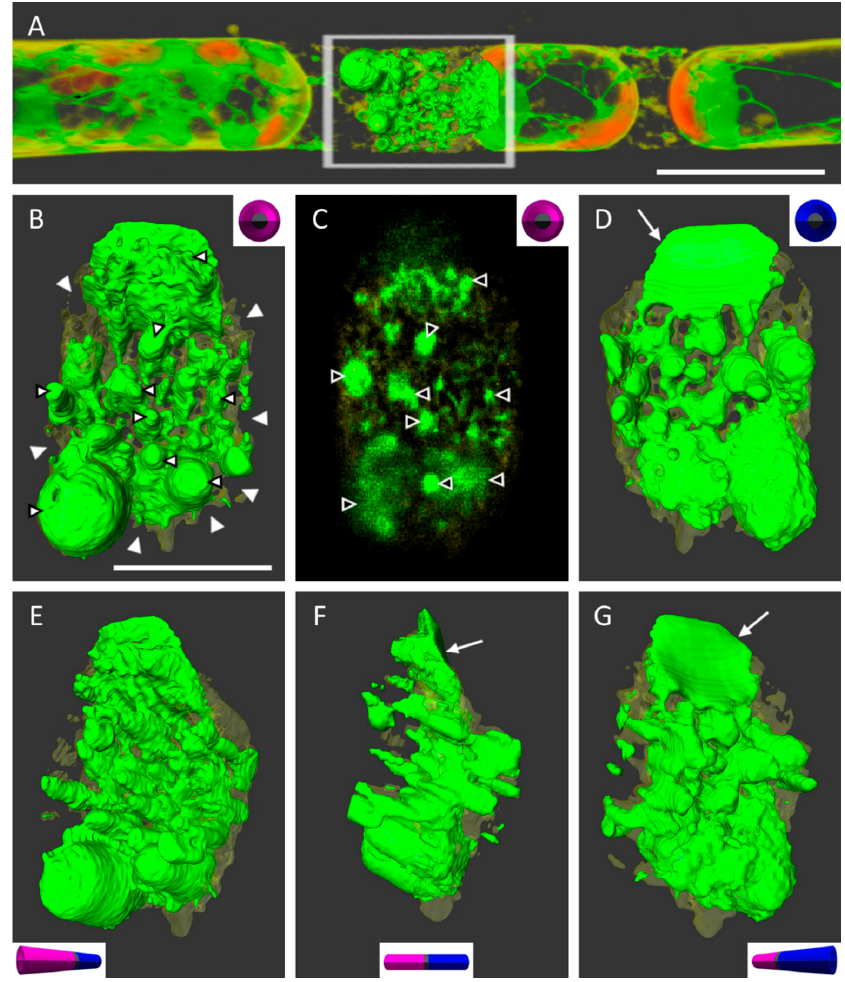
Figure 4. The cell wall of two adjacent caulonema cells after plasmolysis in 0.8 M mannitol. ( A ) Overview of subprotoplasts with partial 3D reconstruction of the situation at the connecting cell wall with the P-X detachment form. ( B , D – G ) Volume renderings of membranes (ER in green, PM in yellow) and views from various angles. ER and its surrounding membranes form lateral notches and little holes after plasmolyzing (white arrowheads). ( C ) A virtually generated slice through the wall, revealing a net of membrane and ER. ( B , C ) Some ER structures possibly extend into both cells (black-white arrowheads). ( D , F , G ) Arrows mark the protoplast attachment of the right cell (blue part in the schematic) from ( A ). Scale bar: A = 20 µ m, B = 10 µ